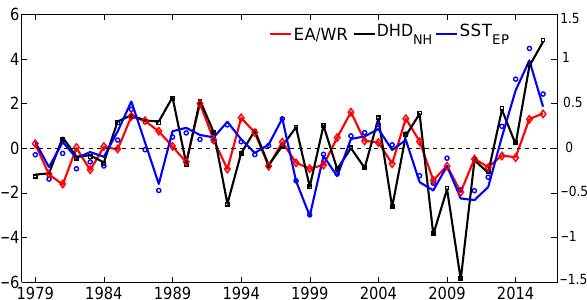
Figure 11. Variation of the DHD NH (black), EA/WR pattern (red), and SST EP (blue) indices from 1979 to 2016. The solid lines indi- cate the indices whose linear trends were removed and the symbols without lines were the original indices.